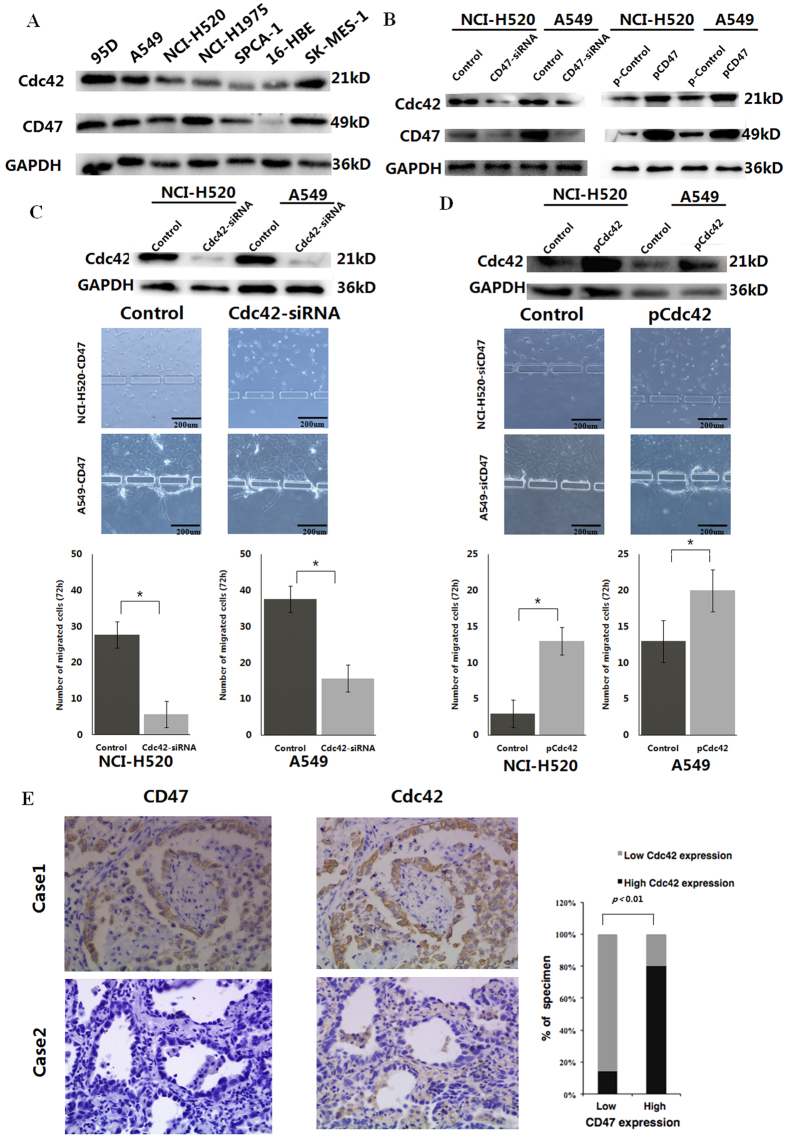
CD47 expression correlates with Cdc42 expression in NSCLC.(A) Western blotting analysis on CD47 and Cdc42 protein expression in indicated NSCLC cell lines. (B) Western blotting analysis of CD47 and Cdc42 expression in A549 and NCI-H520 cells transfected with CD47-siRNA vs. control siRNA (left) and A549 and NCI-H520 cells transfected with pcDNA3.1-3xFlag-CD47 vs. control vector (right). (C) Representative images and quantification of invading CD47-expressing A549 and NCI-H520 cells transfected with control siRNA or Cdc42-siRNA; *P < 0.05. (D) Cdc42 overexpression rescued the effects of CD47 siRNA on A549 and NCI-H520 cell migration and invasion; *P < 0.05. (E) Representative IHC images and quantification of NSCLC specimens show the correlation between CD47 expression and Cdc42 expression. Error bars represent the means of three independent experiments.